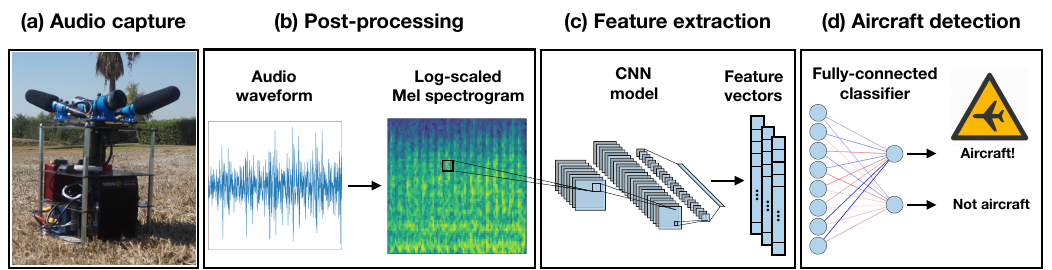
Figure 2. Proposed ‘Detect and Avoid’ system which goes from capturing a sound to detecting an aircraft. CNN and classifier schematics generated using NN-SVG